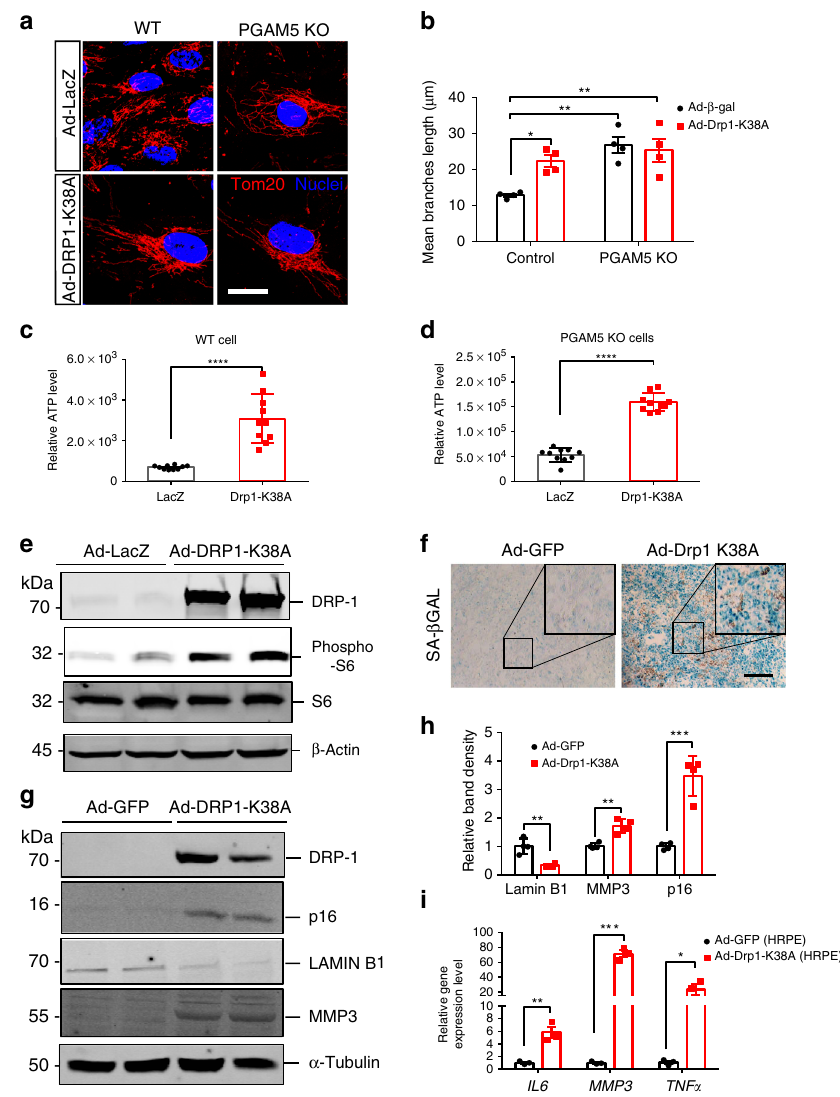
Fig. 5 Drp1-K38A overexpression phenocopies PGAM5 − / − mitochondrial phenotype and cell senescence. a Tom20 immunostaining in WT and PGAM5 − / − ARPE-19 cells infected with adenovirus expressing Ad-LacZ or Drp1-K38A mutant, showing that Ad-Drp1-K38A mutant mimics PGAM5 − / − hyperfusion phenotype. Scale bar = 20 µ m. n = 4. b Quanti fi cation of mitochondrial branches in a using ImageJ. n = 4, * p < 0.05, ** p < 0.005, analyzed by two-way ANOVA Tukey ’ s multiple comparisons test. Error bars, mean ± s.e.m. c ATP production in WT ARPE-19 cells overexpressing Ad-LacZ or